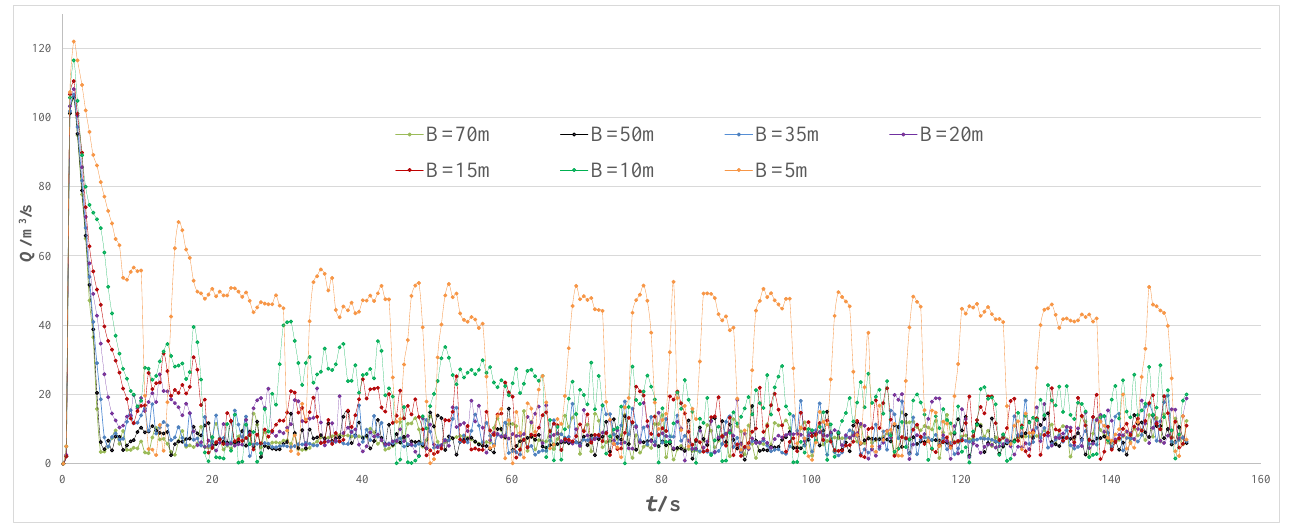
Figure 8. Changes in volumetric flow rate per unit width at the track point marked in Figure 7 over time for different breach widths.